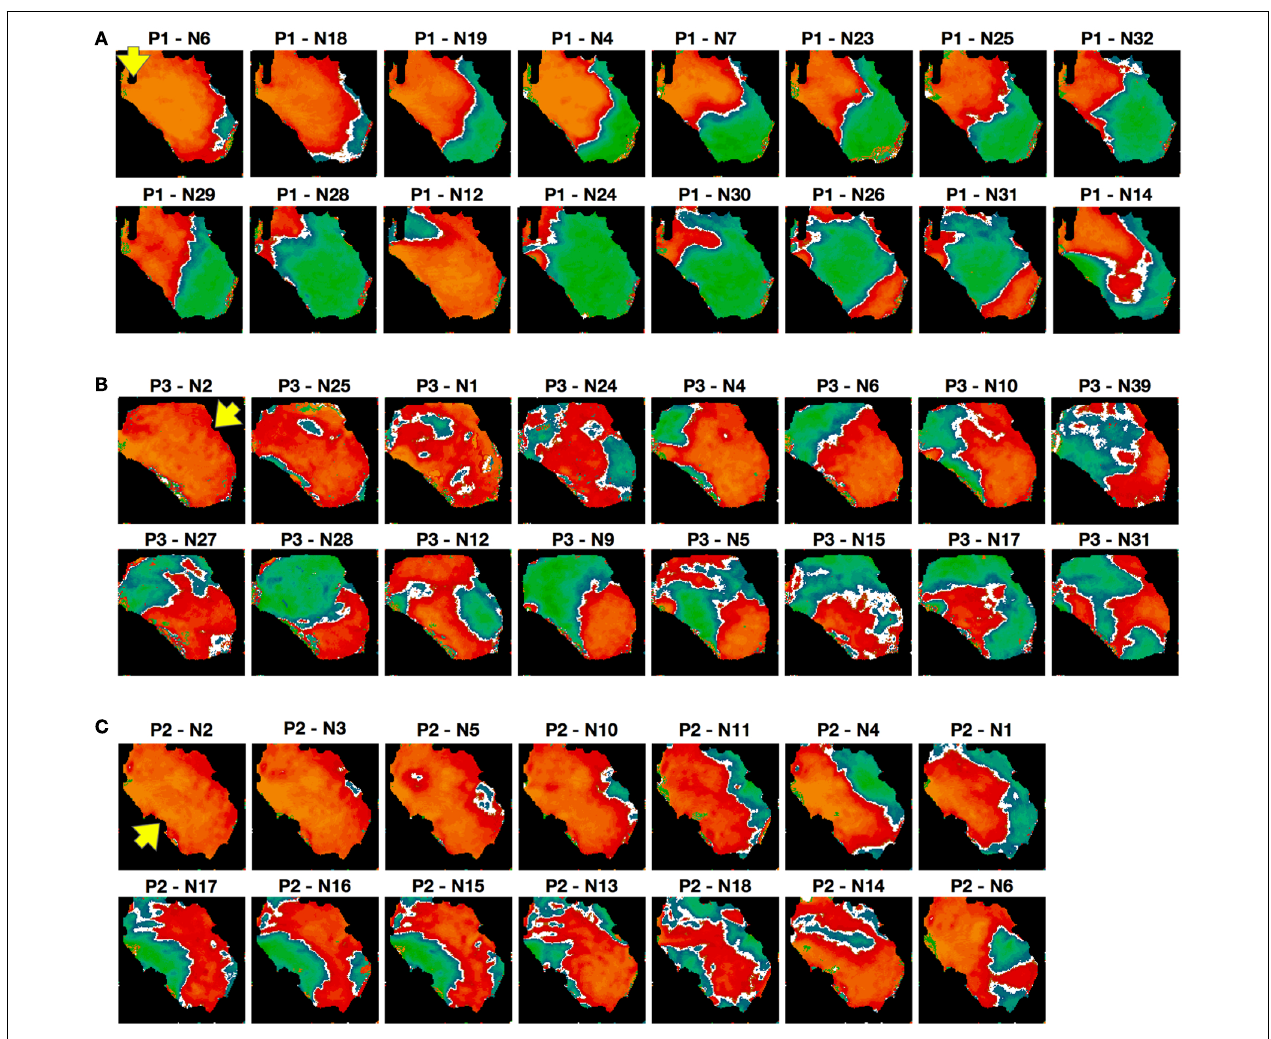
similarity with a main axis of 7cm, but it is important to note that their appearance is not in chronological order (the experiment number is indicated on top of each panel). Pacing sites are indicated by the arrows [RV posterior in (A) apex in (B) and base in (C)